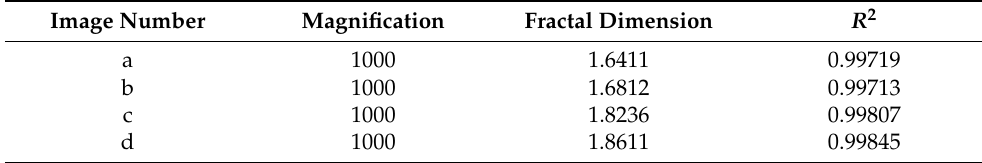
where D is the degree of damage, f is the fractal dimension, f 0 is the fractal dimension of gypsum rock in the natural state, and f max is the maximum fractal dimension of the research object. Note that the maximum fractal dimension of the two-dimensional plane is two. Table 2. The fractal dimension of the gypsum rock with different immersion times. Image